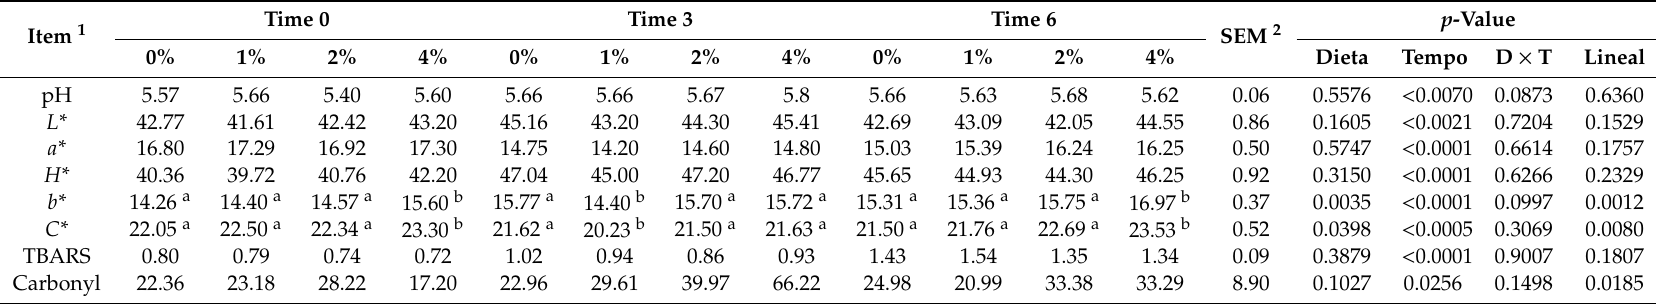
Table 2. E ff ect of dietary treatment with yerba mate extract and retail display time (0, 3, and 6 days) on the physical and oxidative stability of lipids and proteins in the Longissimus thoracis muscle of